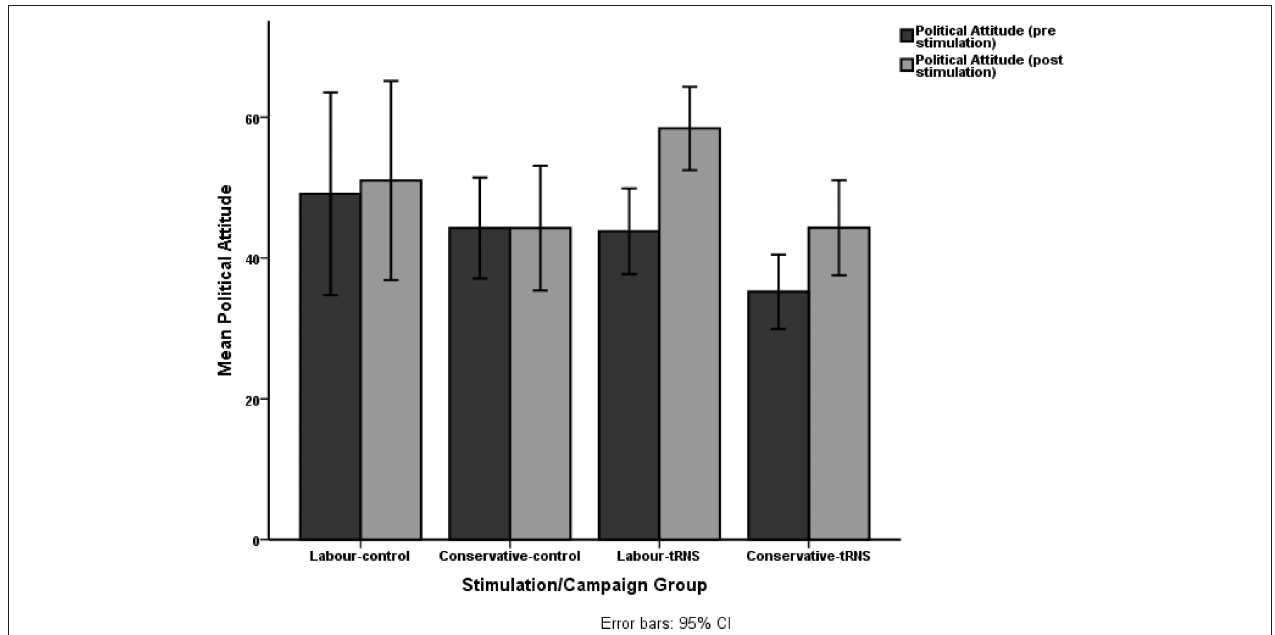
FIGURE 3 | Political attitude scores: Pre-post stimulation campaign.